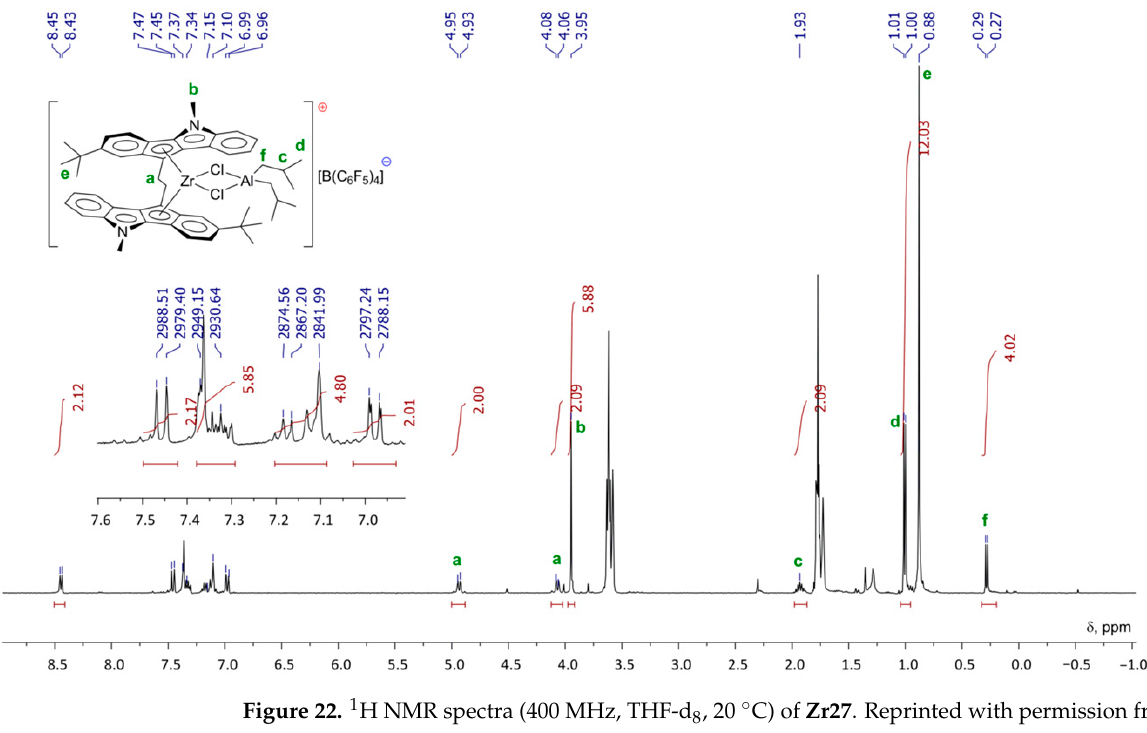
Figure 22. 1 H NMR spectra (400 MHz, THF-d 8 , 20 °C) of Zr27 . Reprinted with permission from [43]. Copyright (2022) Elsevier B.V.